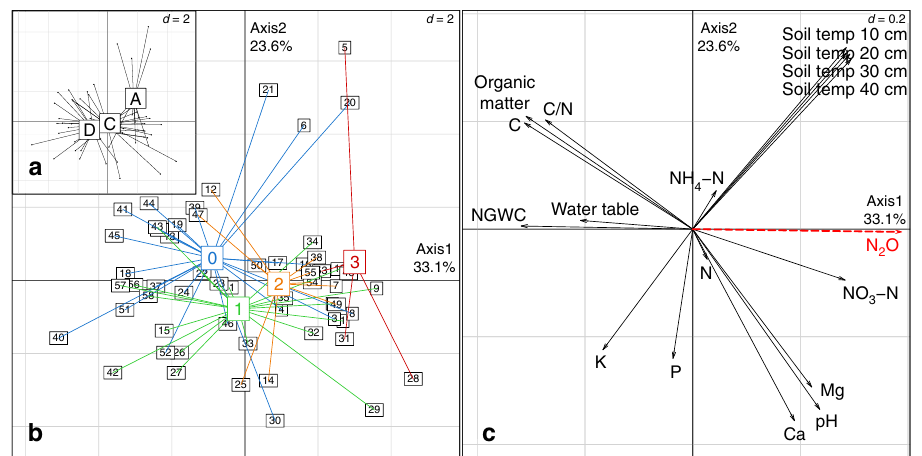
Fig. 2 Ordination plots based on principal component analysis grouping sites and variables. a Köppen climates (A) tropical, (C) temperate and (D) boreal; b intensity of agricultural use (0) no agriculture, (1) moderate grazing or mowing, (2) intensive grazing or mowing and (3) arable; c